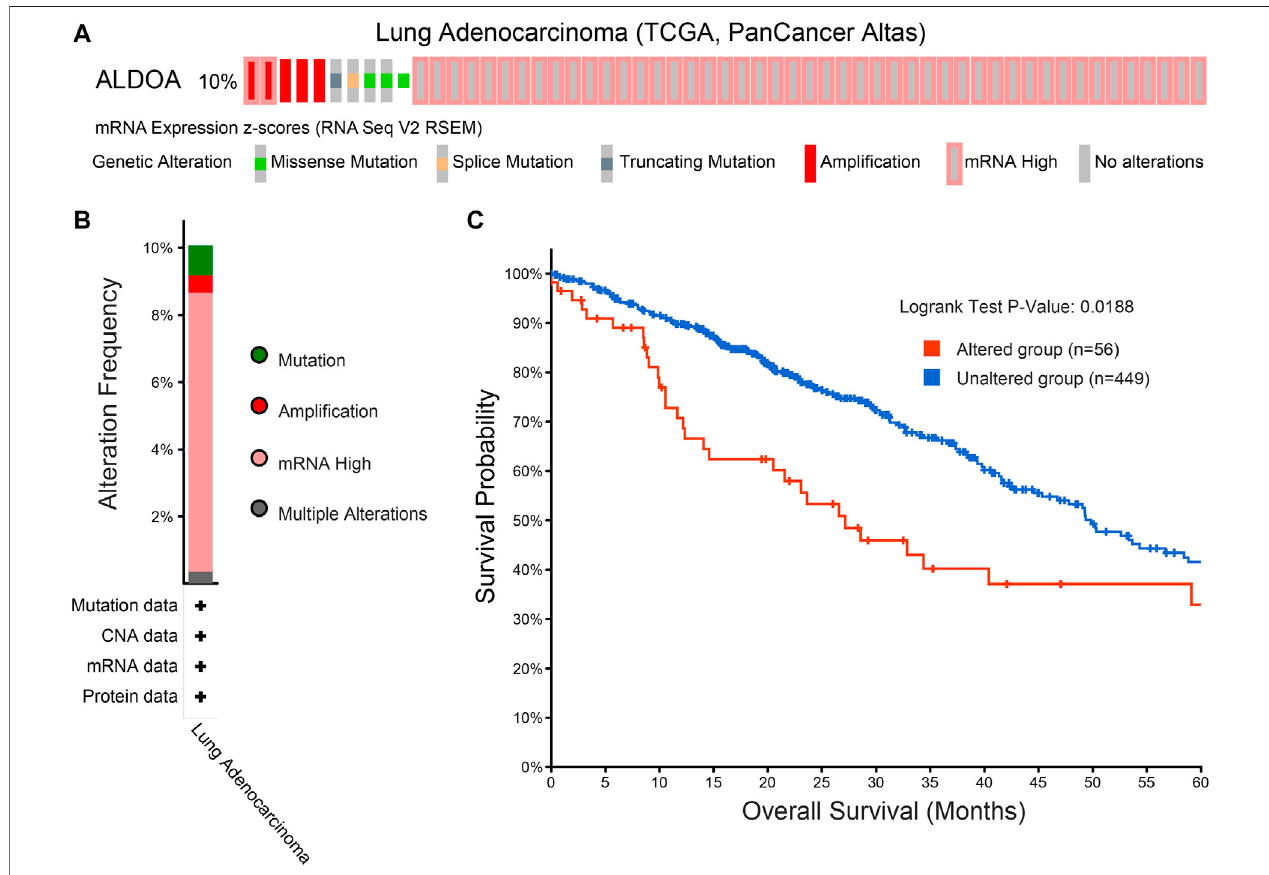
FIGURE7| GenomicmutationofALDOAinlungadenocarcinoma (A) OncoPrintofc-BioPortalshowedthedifferentmutationtypesandproportionsof ALDOA (B) Cancer types summary showed the genomic alteration types in lung adenocarcinoma (C) Genomic mutation of ALDOA was correlated with poor overall survival in lung